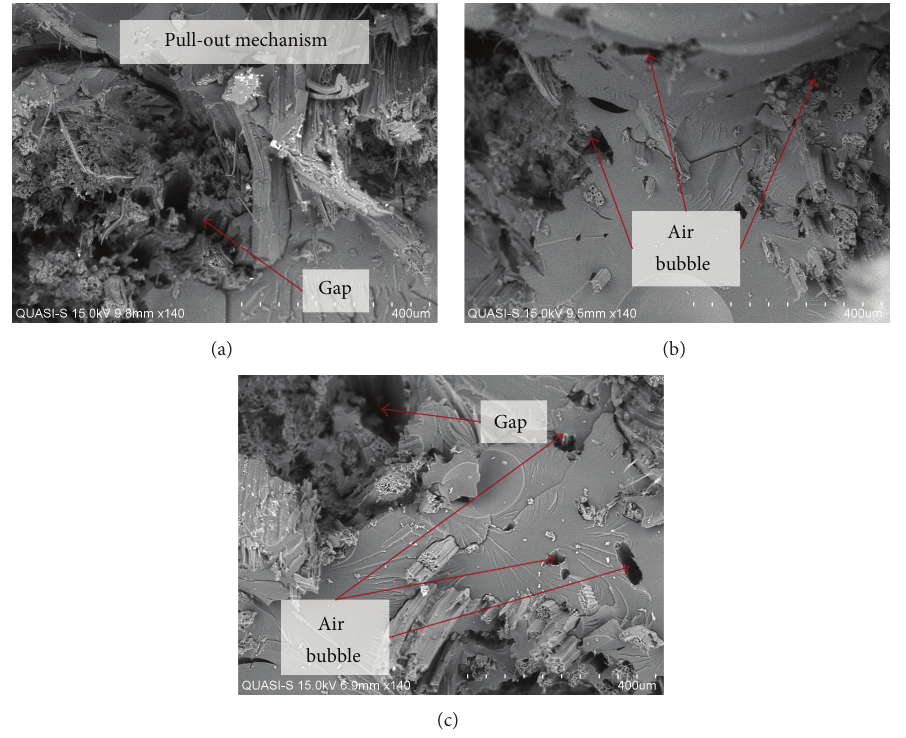
Figure 17: SEM analysis on sample 4 (type B) kenaf